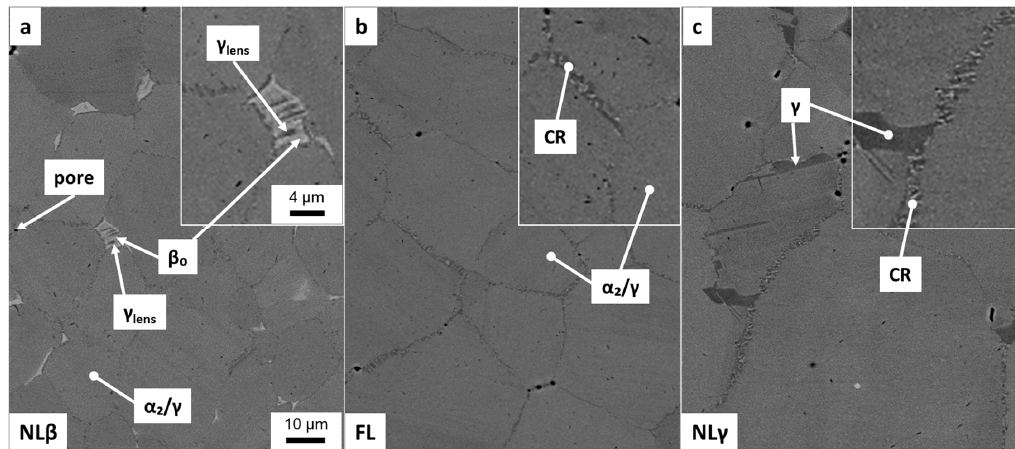
Figure 2. SEM micrographs of microstructures after two-step heat treatment according to Table 1: ( a ) NL β ; ( b ) FL; and ( c ) NL γ . The inserts in the upper right corner show microstructural details in higher magnification. At this point it should be noted that the pores show an enlarged size, caused by the electrolytically etching procedure (see text). SEM images were taken in BSE mode.